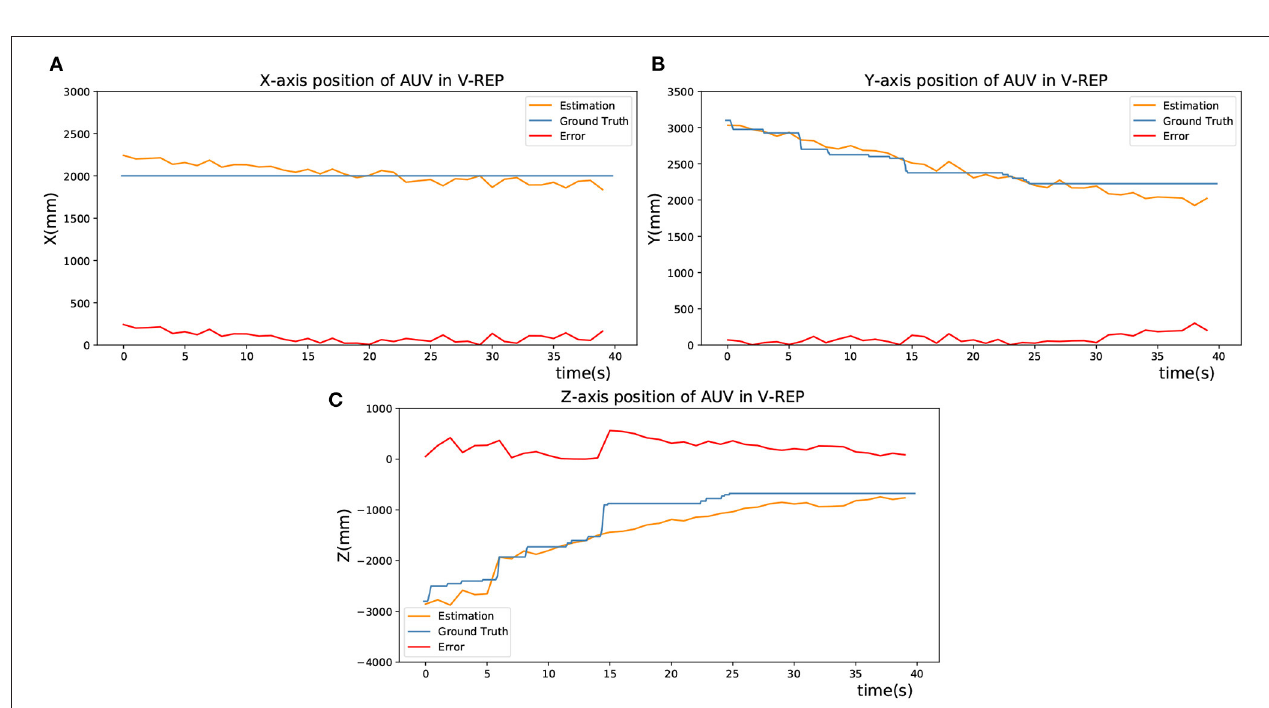
FIGURE 5 | Estimation of the AUV’s position in V-REP. (A) X-axis position of AUV in V-REP. (B) Y-axis position of AUV in V-REP. (C) Z-axis position of AUV in V-REP.